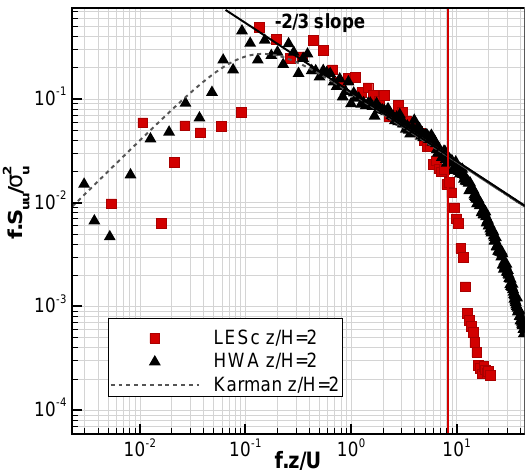
Figure 5. Comparison of the energy spectral density of the streamwise velocity at position x / H = 0, z / H = 2 for HWA (black triangles) and LESc (red squares). The solid black line represents the slope of the Kolmogorov − 2/3 law, the dashed grey line represents the Karman’s Theoretical curve. The solid vertical red line indicates the smallest scale not strongly affected by the sub-grid model and discretization errors with Λ LES ≈ 0.24 H = 12